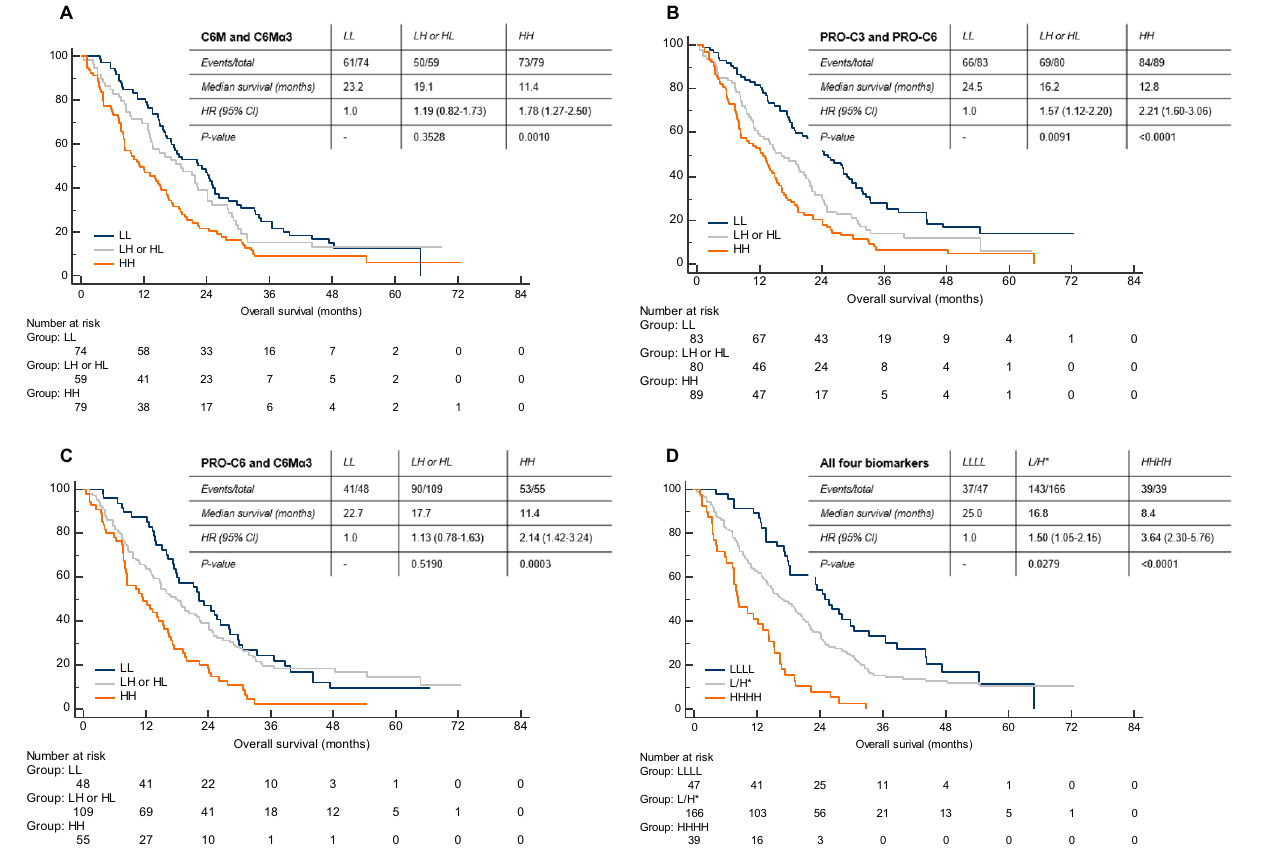
Figure 5. Assessment of the prognostic potential of combining the different biomarkers by Kaplan Meier plots. ( A ) LL; low C6M and low C6Mα3, LH or HL; low C6M and high C6Mα3 or high C6M and low C6Mα3, HH; high C6M and high C6Mα3. ( B ) LL; low PRO-C3 and low PRO-C6, LH or HL; low PRO-C3 and high PRO- C6 or high PRO-C3 and low PRO-C6, HH; high PRO-C6 and high PRO-C6. ( C ) LL; low PRO-C6 and low C6Mα3, LH or HL; low PRO-C6 and high C6Mα3 or high PRO-C6 and low C6Mα3, HH; high PRO-C6 and high C6Mα3. ( D ) LLLL; low PRO-3, PRO-C6, C6M and C6Mα3, L/H*; at least one low or high PRO-C3, PRO- C6, C6M or C6Mα3, HHHH; high PRO-C3, PRO-C6, C6M and C6Mα3. Univariate Cox proportional-hazards regression was used to calculate the hazard ratios (HR) with 95% Cl and p -values. A p < 0.05 was considered